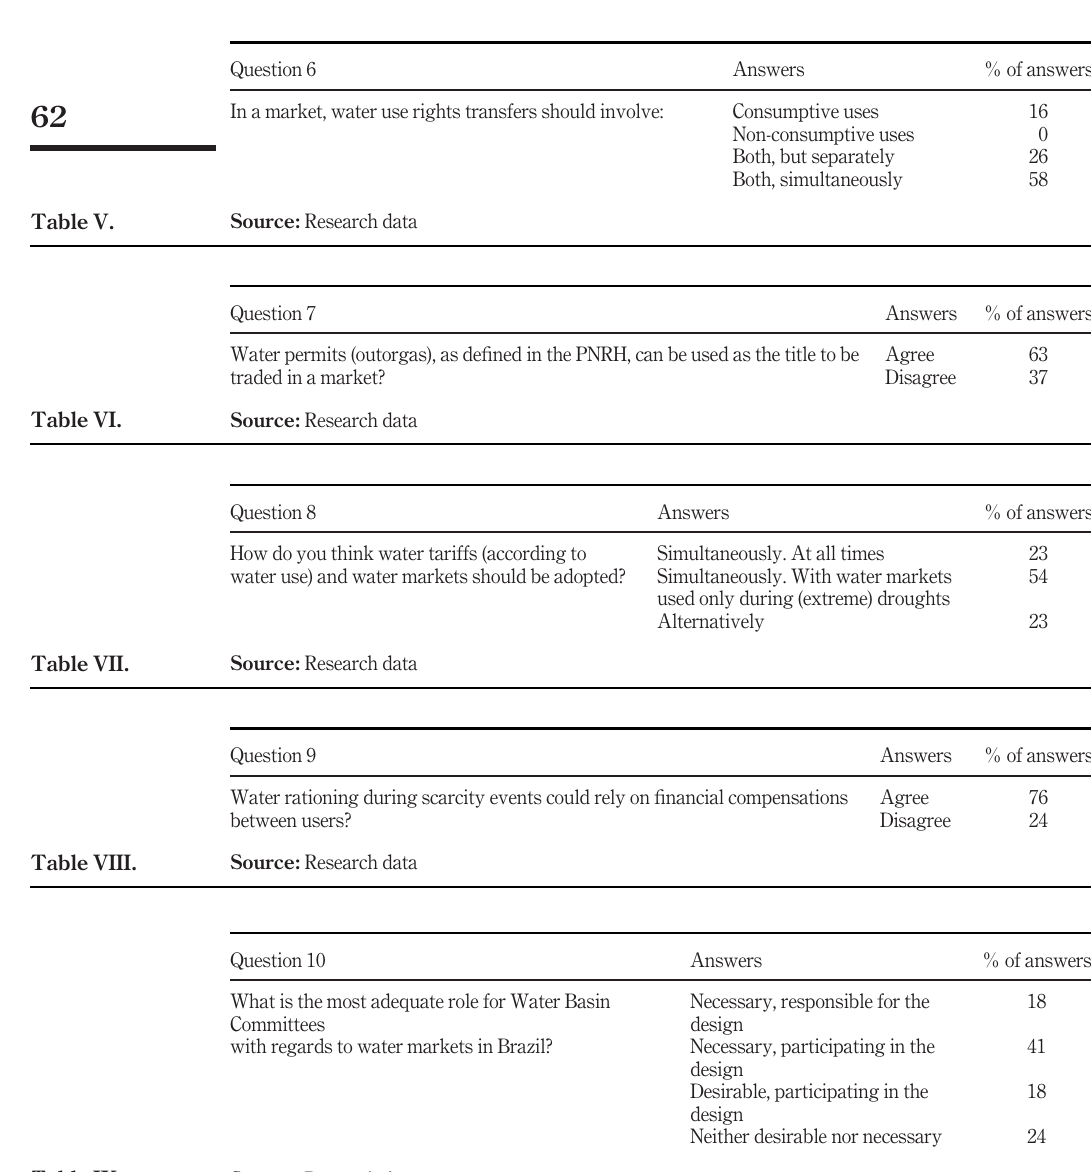
Necessary, responsible for the